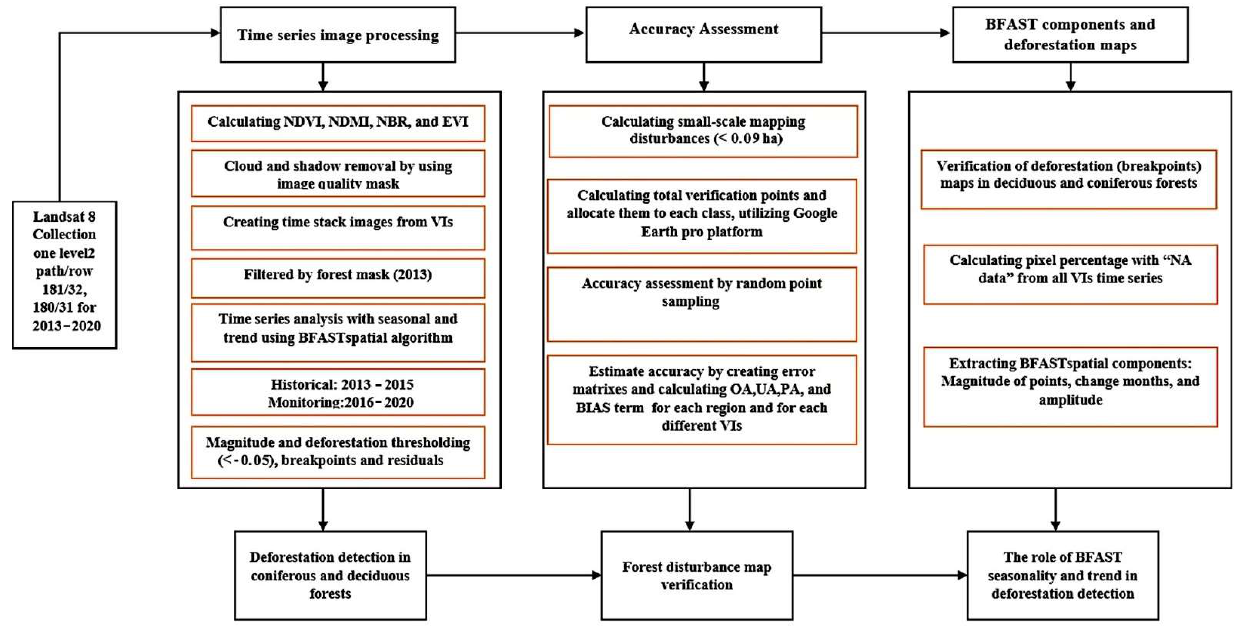
Figure 2. Methodological flowchart of the study.